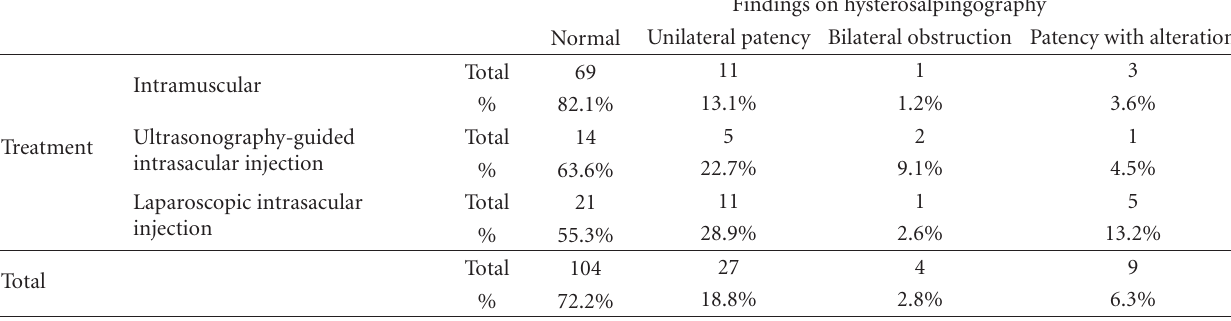
Table 2: Findings on hysterosalpingography according to initial treatment modality for ectopic pregnancy. Results are expressed as frequencies and percentage ( P = 0 . 025).